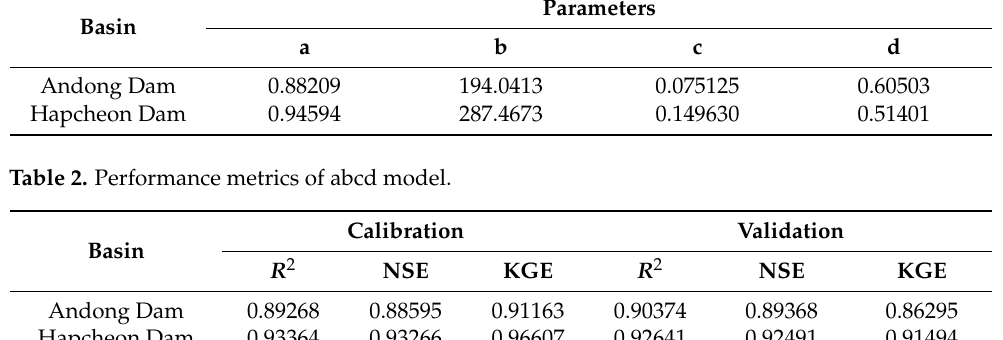
Table 1. Parameters estimated for abcd model.